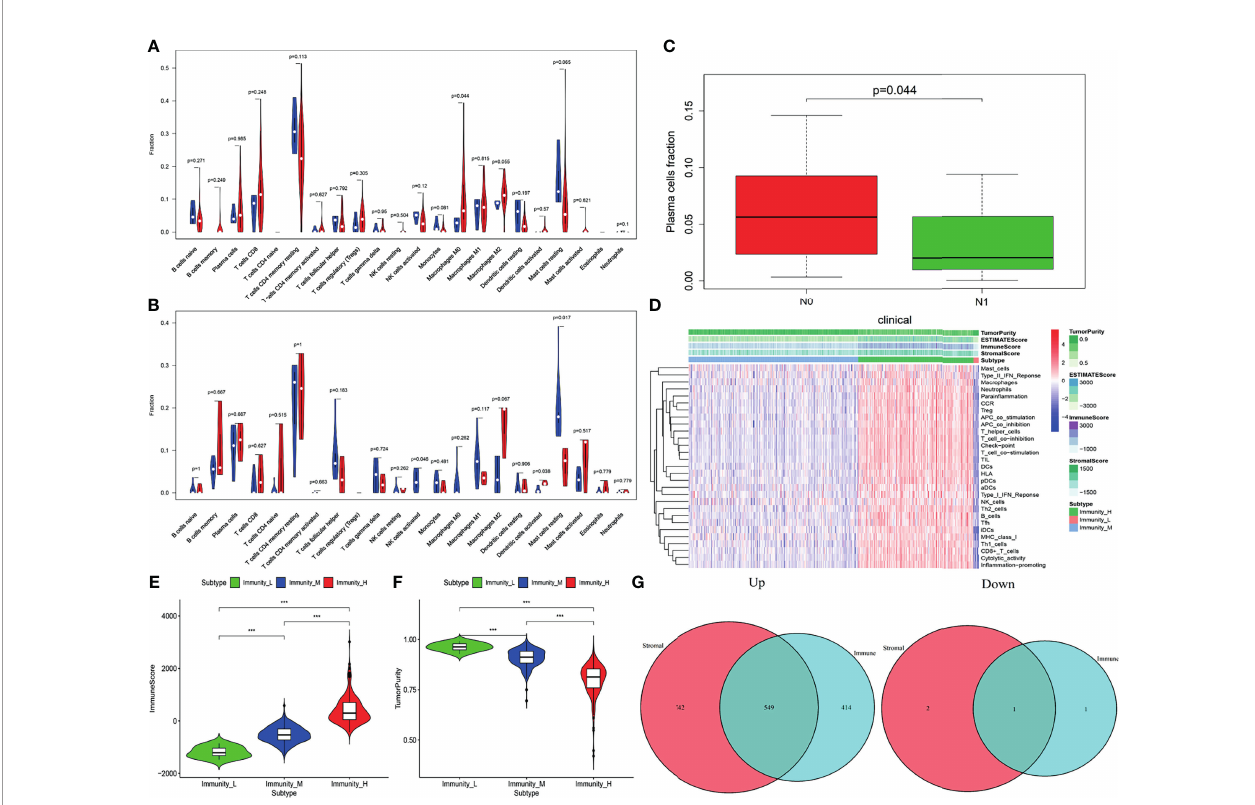
FIGURE 1 | (A, B) The distribution and abundance difference of tumor-in fi ltrating immune cells (TIICs) in normal and cancerous tissues of the prostate. Red indicates tumor tissues, and blue indicates normal tissues [ A , The Cancer Genome Atlas (TCGA) cohort; B , Gene Expression Omnibus (GEO) cohort]. (C) Correlation of in fi ltrating plasma cell fraction with clinical features in prostate cancer (PRAD) patients. N, lymph node, which represents the presence and extent of regional lymph node metastasis; N0 means that the lymph node is not involved, and N1 means that the lymph node is involved. (D) A heat map of the relationship between the proportion of 29 immune-related gene sets and tumor purity, microenvironment score (including matrix score and immune score), and sample immune subtype based on TCGA data. Red means upward regulation; blue means downward regulation. (E, F) Relationship between immune scores (E) and tumor purity (F) and sample immune subtypes. The relative numerical values corresponding to the height of the histogram indicate the different levels of abundance and the proportions (***P ≤ 0.001). (G) The upregulated and downregulated differential genes of stromal score groups and immune score groups were obtained, respectively (549 upregulated genes and one downregulated